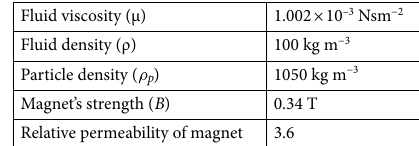
Table 1. Physical properties considered for